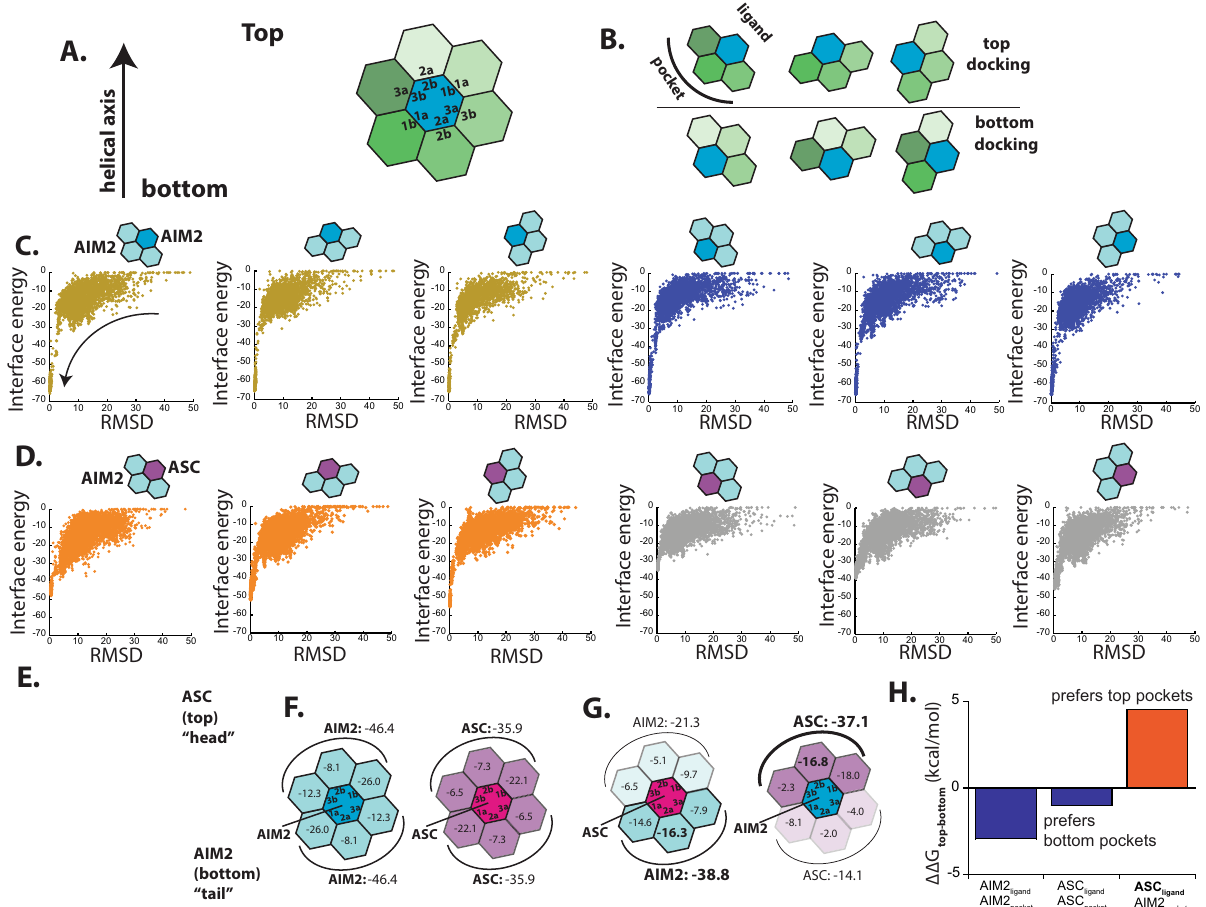
Fig. 2 In silico studies suggest that homotypic fi laments assemble bidirectionally and the recognition between AIM2 and ASC occurs unidirectionally. A Cartoon representations of honeycombs. Each interface type is labeled in the hexagons which represent PYD monomers. B Rosetta docking strategy. Top docking indicates that a ligand monomer docks onto the top surface of the pocket, while bottom docking is the opposite. C Plots of Rosetta interface energy scores vs. RMSD for top and bottom docking results for AIM2 PYD assembly. The B represents simulations conducted in C . D Plots of Rosetta interface energy scores vs. RMSD for docking an ASC PYD monomer on the top or bottom of AIM2 PYD pockets. E A model of the AIM2 PYD fi lament recognition of the ASC PYD fi lament. F , G Rosetta interface energy scores at individual fi lament interfaces for homotypic and heterotypic assemblies. AIM2 PYD -AIM2 PYD , ASC PYD -ASC PYD , ASC PYD -AIM2 PYD , and AIM2 PYD -ASC PYD . Each hexagon represents AIM2 PYD or ASC PYD monomer. H A plot for the difference in free energy ( ΔΔ G) for dissociating ligand PYDs from the top or bottom